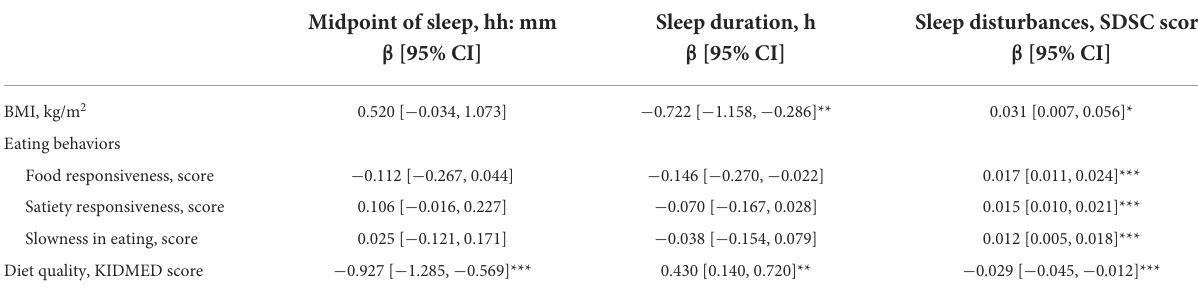
TABLE 2 Associations between sleep dimensions and body mass index, eating behaviors, and diet quality in school-aged children.